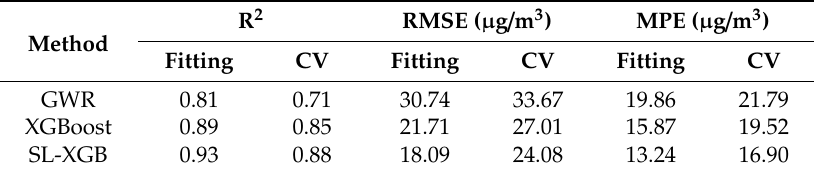
Table 2. Fitting and sample-based CV performance of GWR, XGBoost and